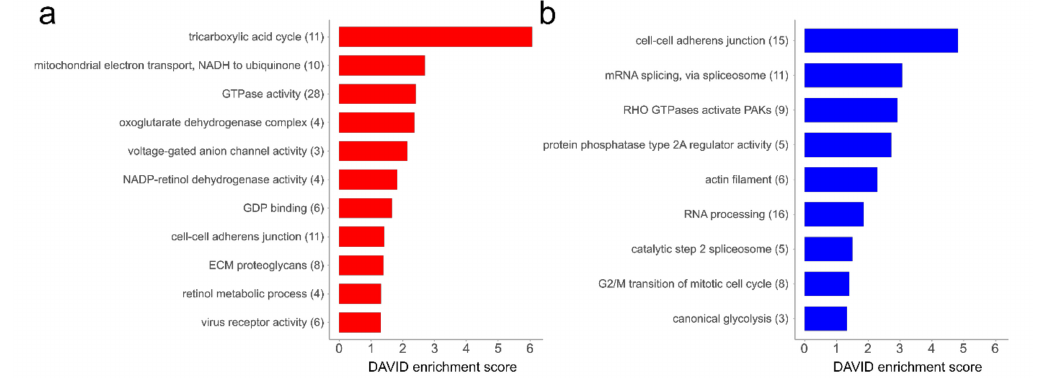
Figure 4. Enriched Database for Annotation, Visualization, and Integrated Discovery (DAVID) annotation clusters from proteins more abundant ( a ) and less abundant ( b ) in hp-MKTPCs. The number in brackets behind the term indicates the number of proteins in one cluster. Results with an enrichment score > 1.3 were considered significant. Categories used for the DAVID tool were as follows: Gene Ontology (GO) biological process, GO cellular component, GO molecular function, and reactome. NADH: nicotinamide-adenine dinucleotide, reduced, GDP: guanosine diphosphate PAK: p21 activated